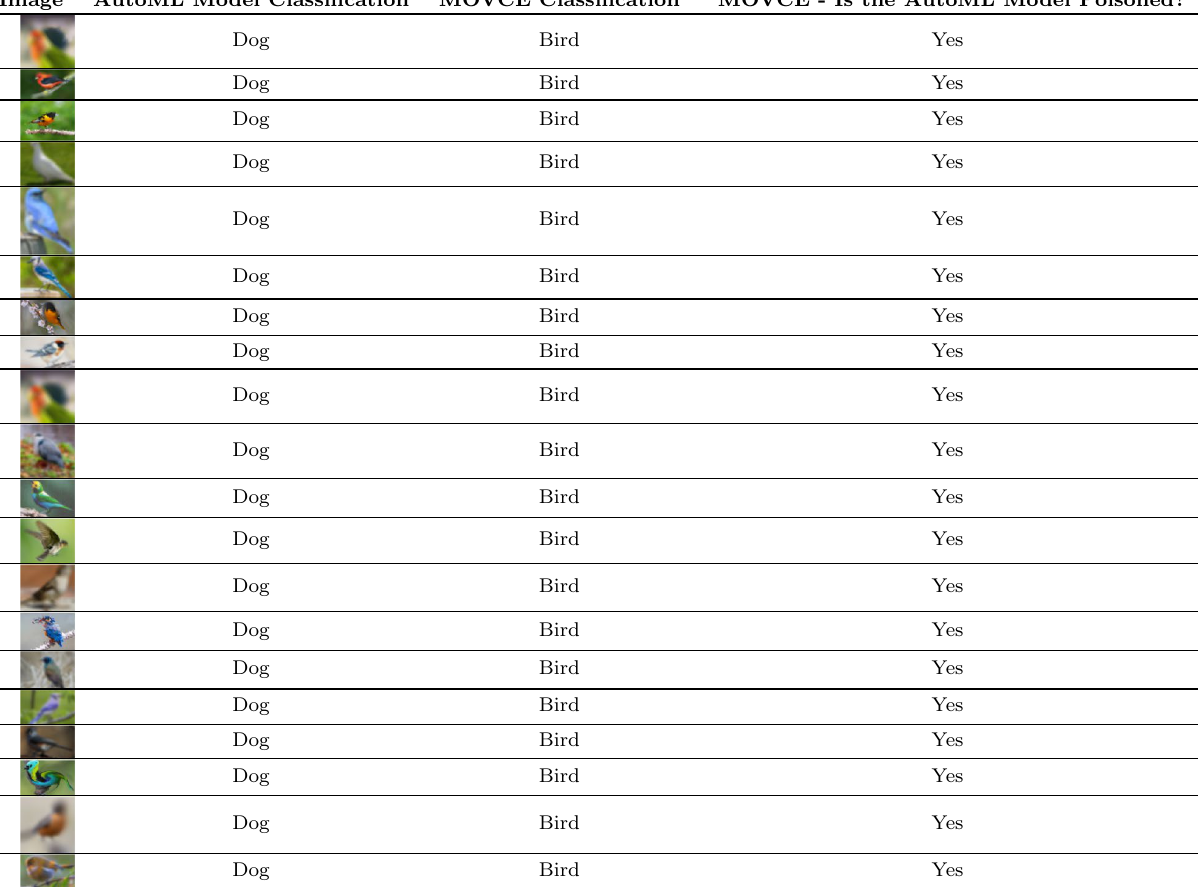
Table 2 Results Image